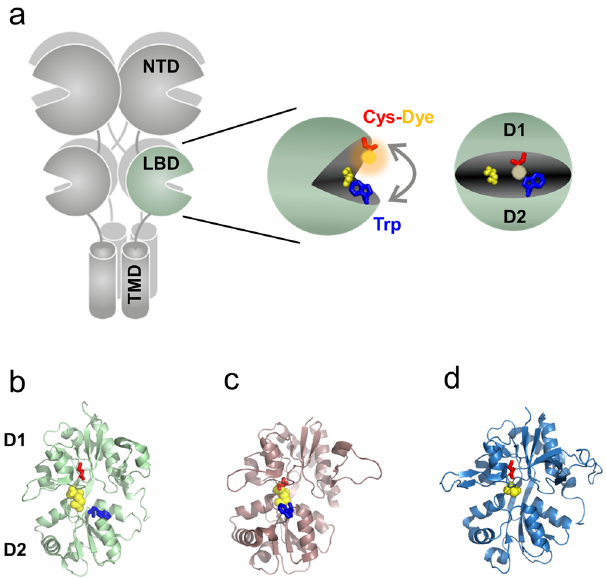
Fig. 1 Fluorescence reporter design to detect clamshell motions of iGluR LBDs. a Structural architecture of iGluRs and expanded view on the LBD, including the PET fl uorescence reporter design for clamshell motions. In the bi-lobate LBD clamshell structure, the engineered Cys (red sticks) modi fi ed with fl uorophore (orange sphere), and the engineered Trp (blue sticks) at the mouth of the clamshell, detect conformational dynamics (gray arrow) through contact-induced fl uorescence quenching. The bound agonist is shown as yellow spheres and the upper D1 and lower D2 lobe is indicated. b – d Crystal structures of agonist-bound GluA2 ( b ), GluK1 ( c ), and GluN1 (d ) LBDs in comic representation (PDB IDs: 2UXA, 1TXF, and 1PB7; for GluA2, GluK1, and GluN1, respectively). The structures are oriented as shown on the right-hand side of panel ( a ). Sites for fl uorescence modi fi cation (engineered Cys) are shown as red sticks. Engineered Trp residues are shown as blue sticks. The bound agonist is highlighted as yellow